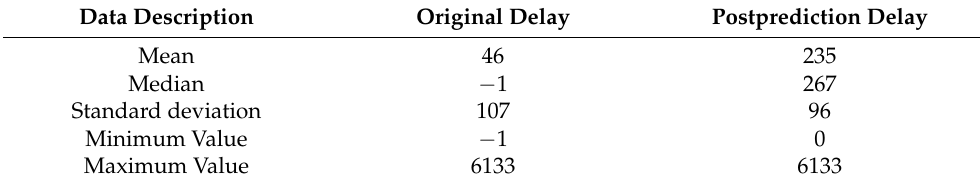
Table 9. Original vs. postprediction delay